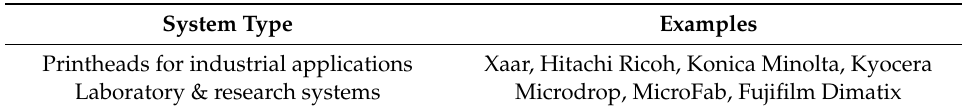
Table 1. Comparison of available inkjet printing systems with respect to their performance and unique